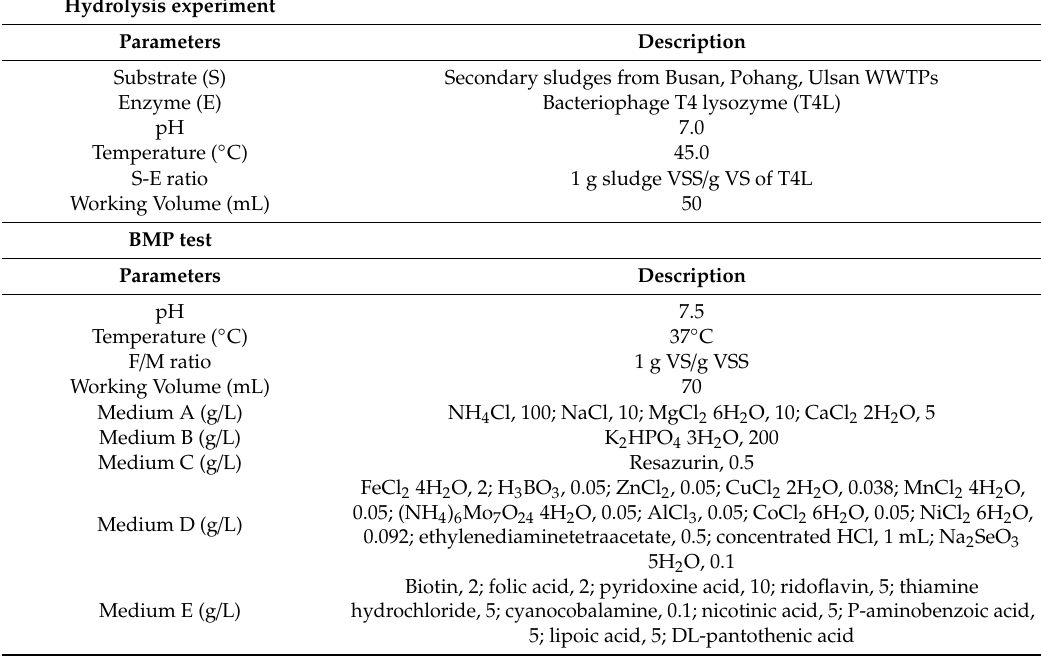
Table 3. Experimental conditions of the hydrolysis e ffi ciency and biochemical methane potential (BMP)